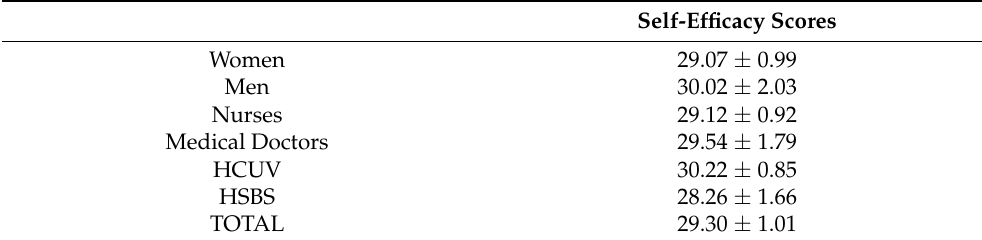
Table 3. Self-efficacy scores regarding gender, professional status (nurses and medical doctors) and